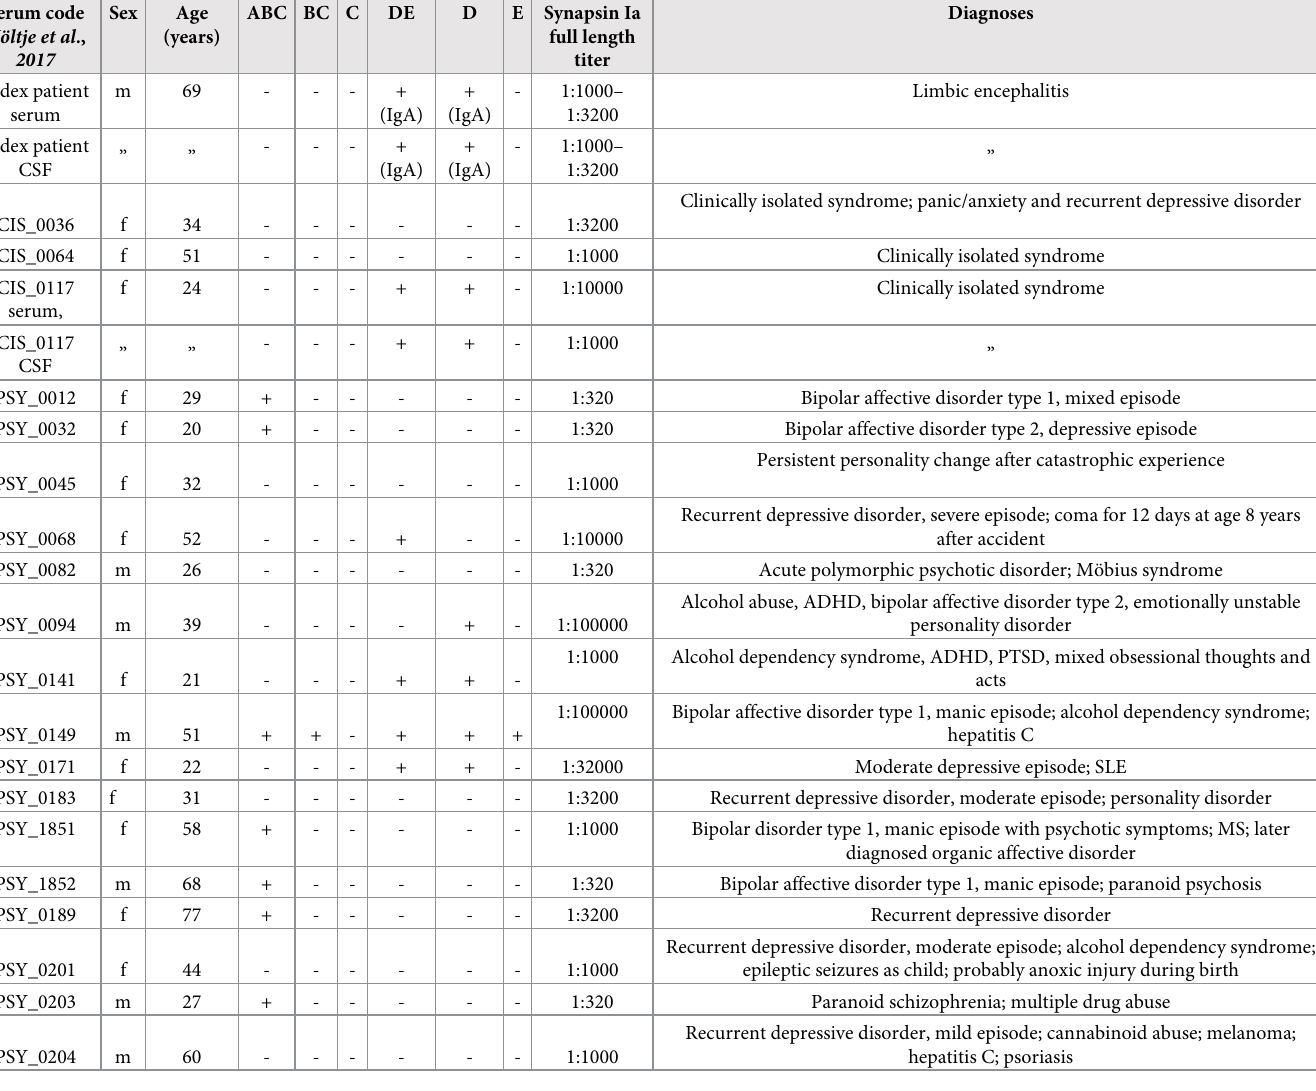
Table 1. Demographic, antibody specificity and clinical findings of the 13 patients with serum or CSF antibodies to synapsin Ia fragments identified in this study. Serum